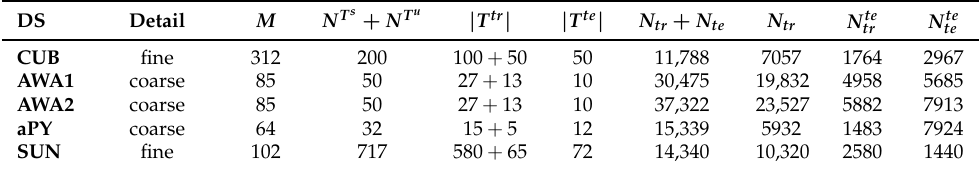
Table 3. Statistics for the